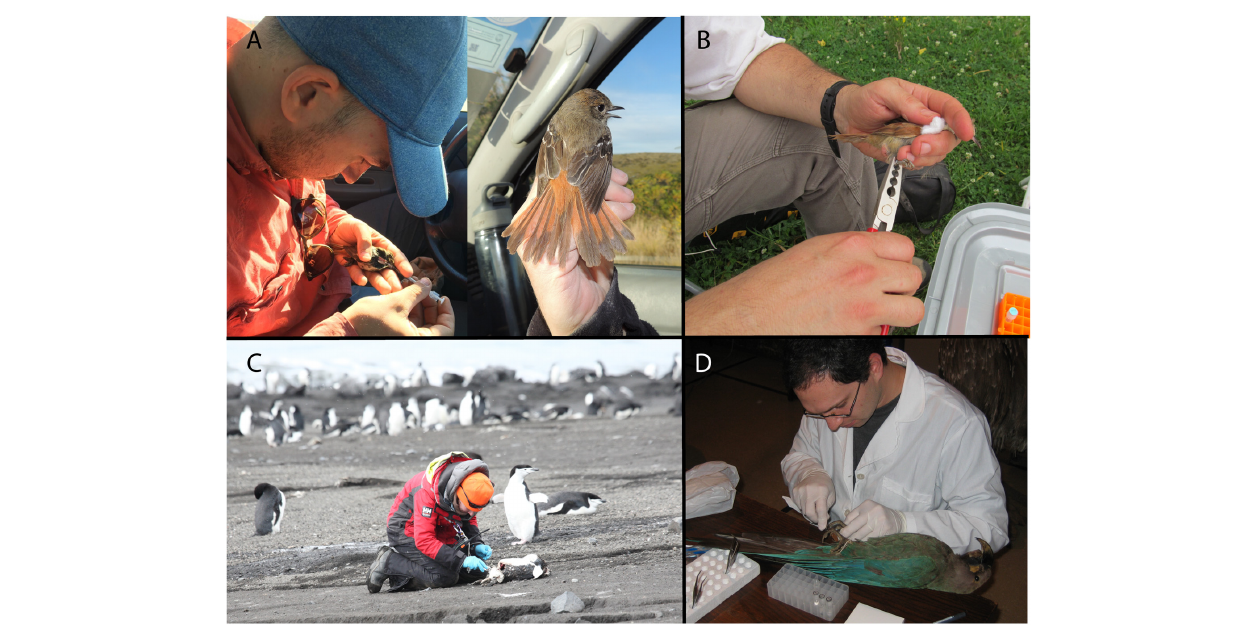
FIGURE 1 | Collection of samples ranges from harvesting eDNA freely available in the environment to euthanizing animals. Here we show scientists obtaining some of the different types of samples from birds that can be used for genetic benchmarking. (A) Left, Pablo Lavinia taking a blood sample from a Hudson’s black-tyrant ( Knipolegus hudsonii , full body shot of the bird to the right). (B) Gustavo S. Cabanne banding a straight-billed reedhaunter ( Limnoctites rectirostris ) after taking a blood sample. (C) Gemma Clucas taking a tissue sample from a chinstrap penguin ( Pygoscelis antarcticus ) found dead on the South Sandwich Islands. (D) Dario Lijtmaer taking a toe-pad sample from a specimen of glaucous macaw ( Anodorhynchus glaucus), a probably extinct species from South America, at the Museo Argentino de Ciencias Naturales. Photos by Ana Barreira [ (A) , left], Pablo Lavinia [ (A) , righ], Jazmín Safarin (B) , Jim Wilson (C) and Pablo Tubaro (D)